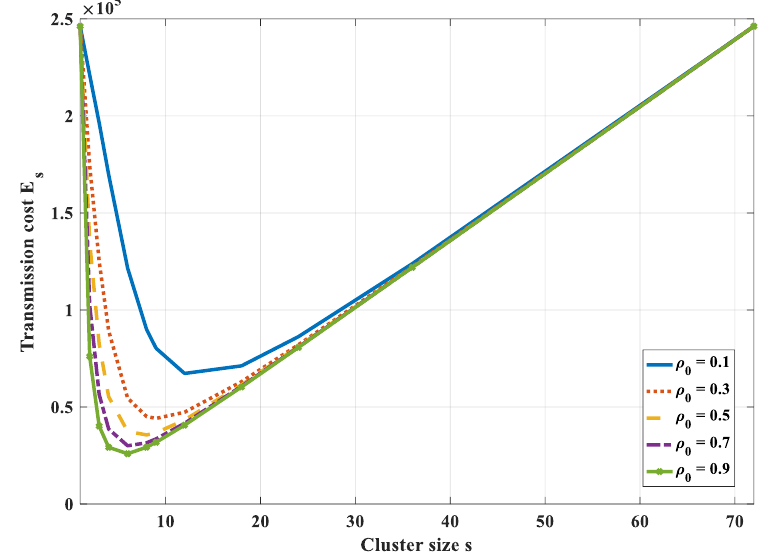
Figure 14. Total bit-hop cost E s , respectively, to cluster size with different values of the entropy correlation coefficient in the case of 2-D with compression at the cluster head only.